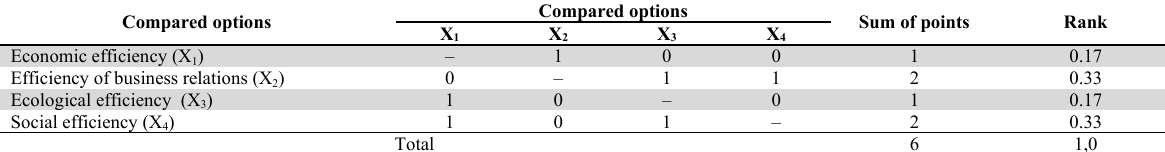
According to Table 6, the highest rank according to the expert № 1 is the efficiency of business relations and social efficiency − 0.33, and the lowest rank - economic and environmental efficiency − 0.17. Using the above calculations of all 10 experts, the values of all experts’ preferences of the main efficiency components of the studied enterprise by priority levels are grouped (Table 7 ). Summary data of experts’ references of the basic activity efficiency components of the studied enterprise Expert